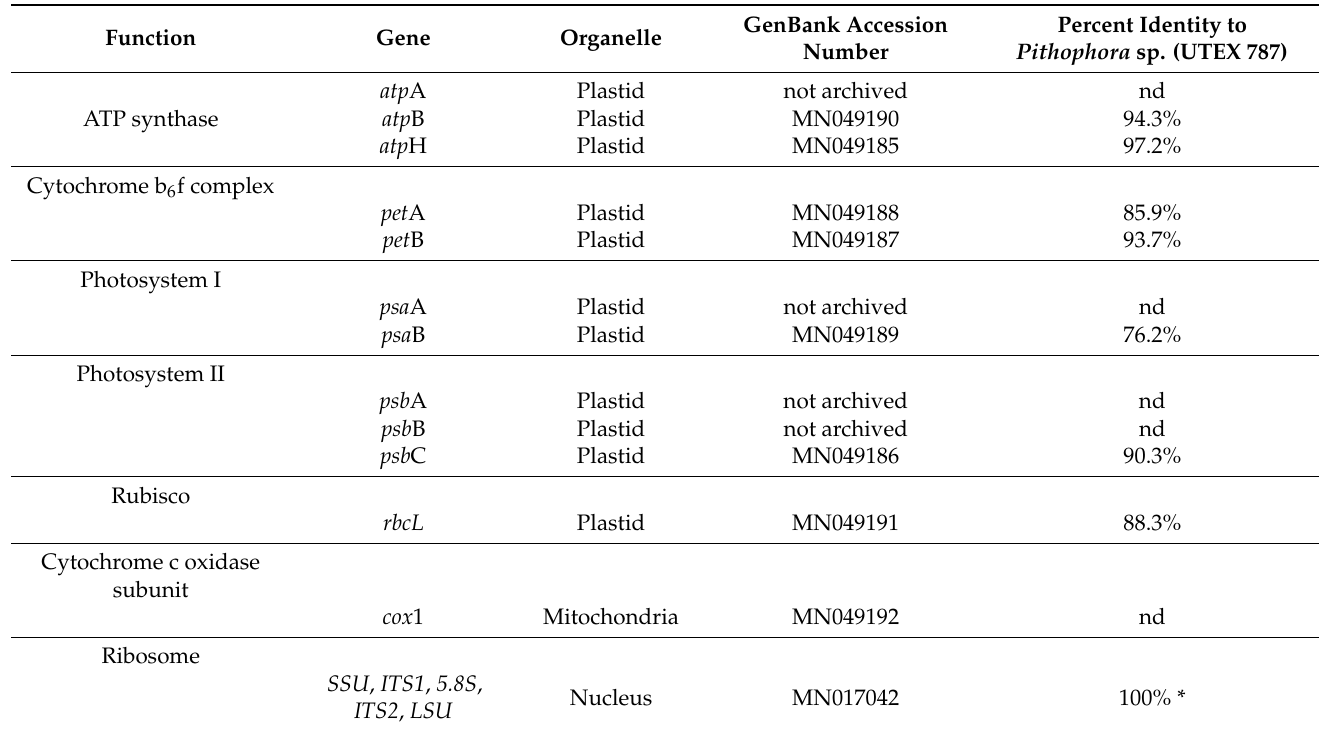
Table 2. Plastid and mitochondrial gene markers sequenced for the present